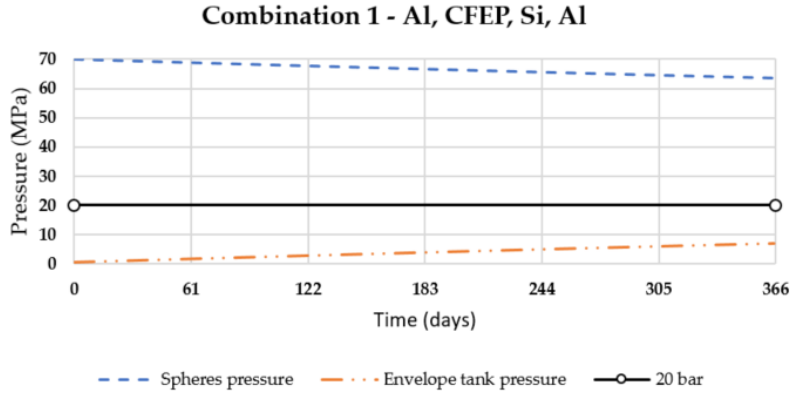
Figure 3. Pressure inside of the spheres and the envelope tank, combination 1 from Table 3.